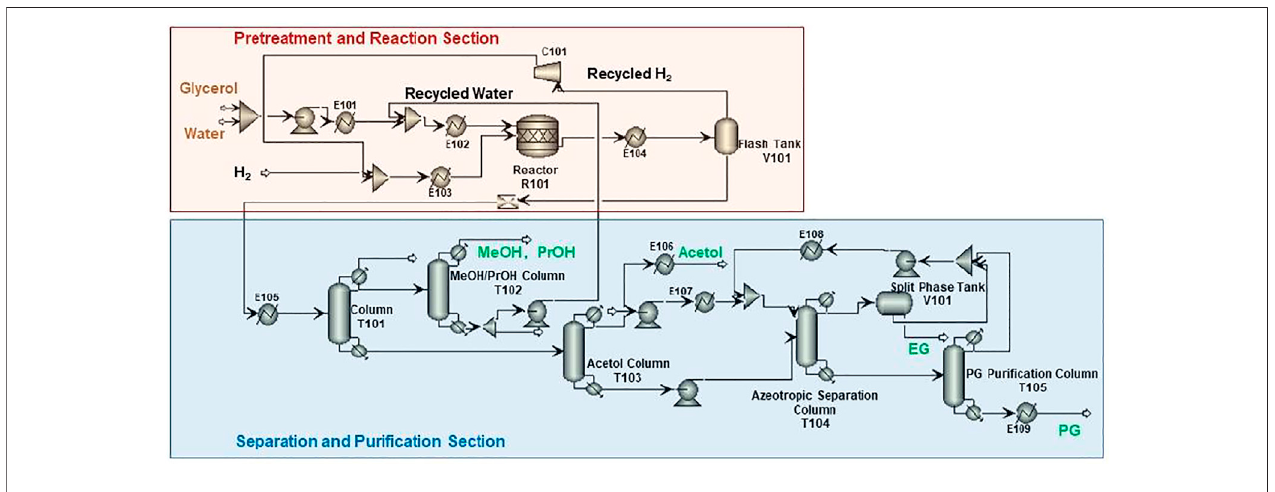
FIGURE 2 | Process scheme for CHDO of glycerol.